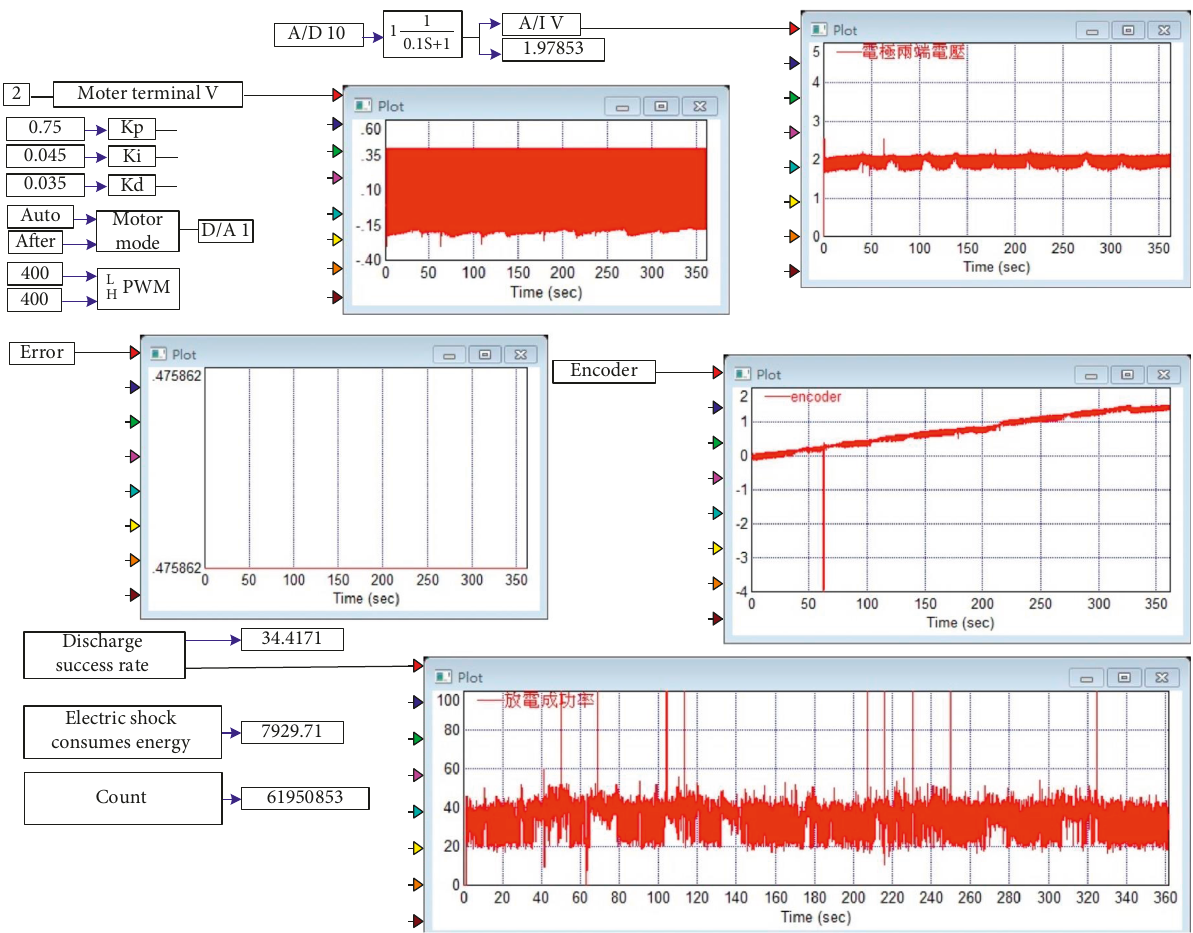
Figure 7: Diagram of Vissim prog. (arcing in DW + PVA for 12 min).